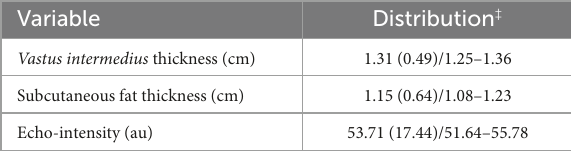
TABLE 1 Demographic, clinical, inflammatory, and functional